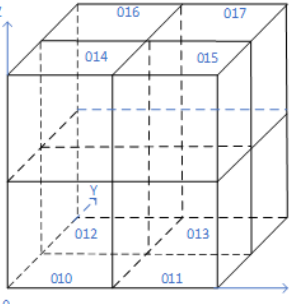
Figure 1. Space partition and coding.